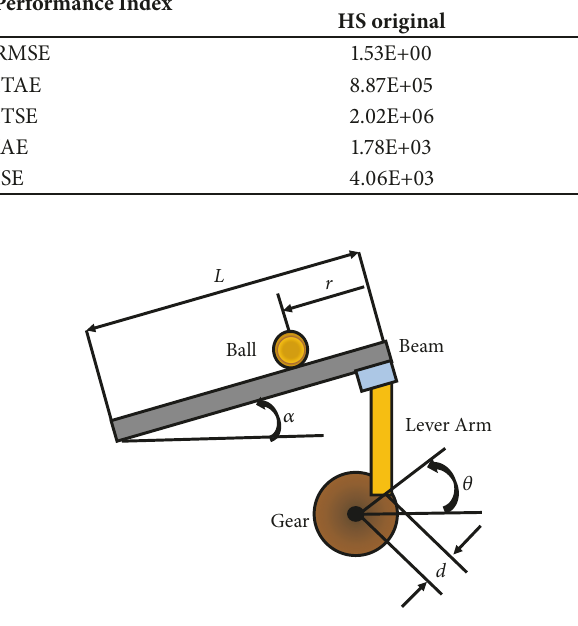
Figure 6: Process of the ball and beam (BB)